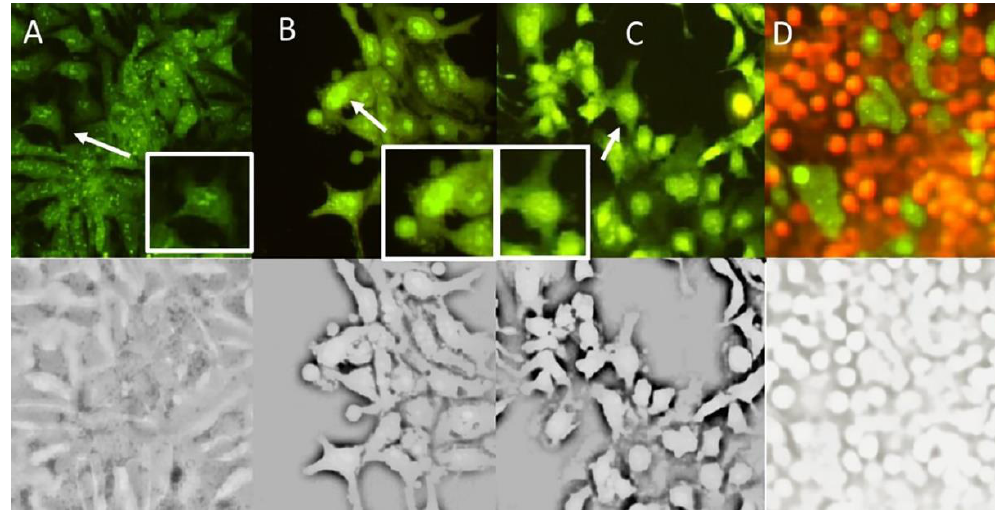
Figure 6. Analysis of cell death in Hep3B cells by using epifluorescence microscopy. ( A ) Negative control (cells without treatment). ( B ) Treatment with Compound 1 to 21.3 µM (12 µg/mL) for 72 h. ( C ) H 2 O 2 apoptosis positive control. ( D ) Necrosis control.